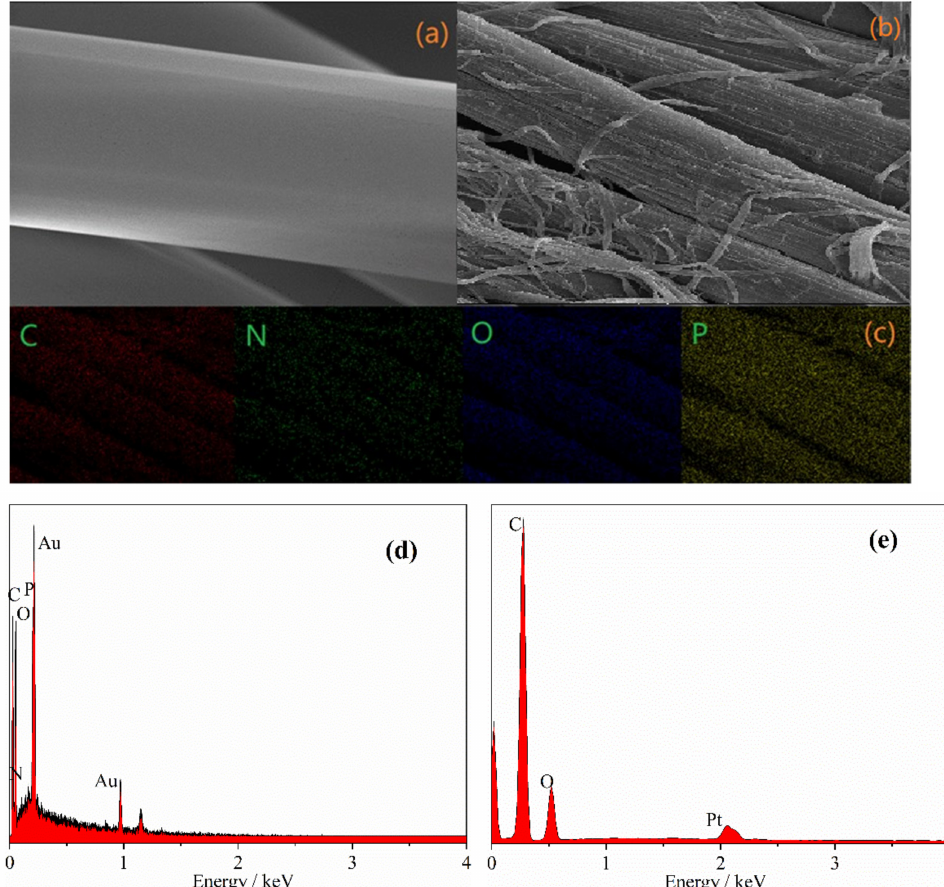
Figure 5. SEM images of lyocell ( a ) and FR − lyocell ( b ) fabrics; SEM − mapping images of FR − lyocell ( c ), EDX spectra of FR − lyocell ( d ), and lyocell ( e ) fabrics,